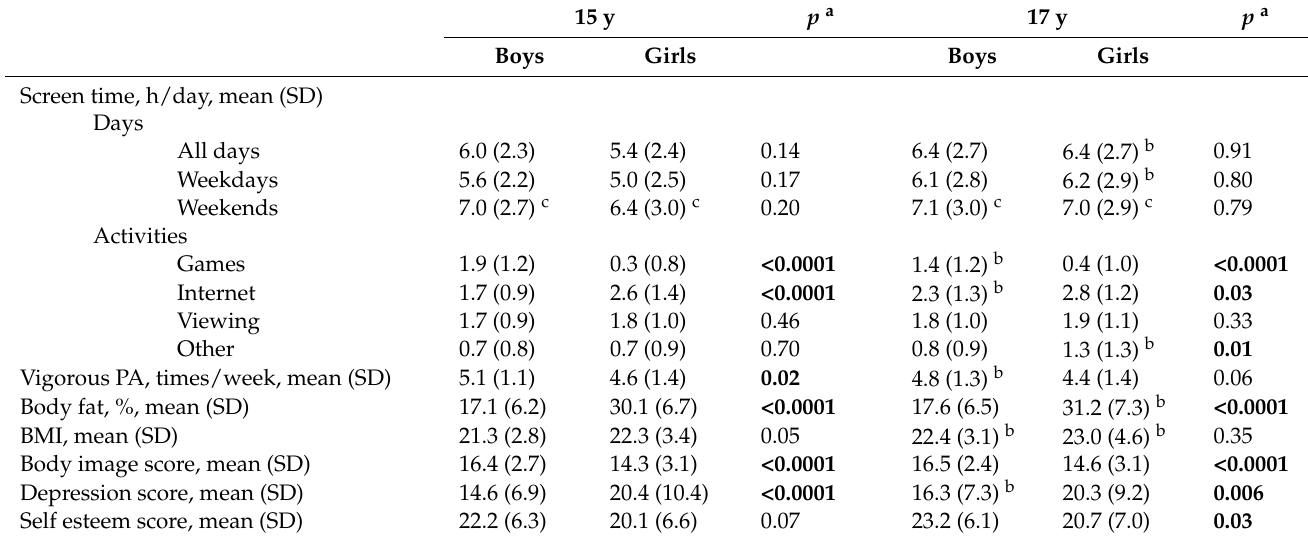
Table 1. Characteristics of the study subjects (57 boys and 95 girls) at age 15 and 17. 15 y p a 17 y p a Boys Girls Boys Girls